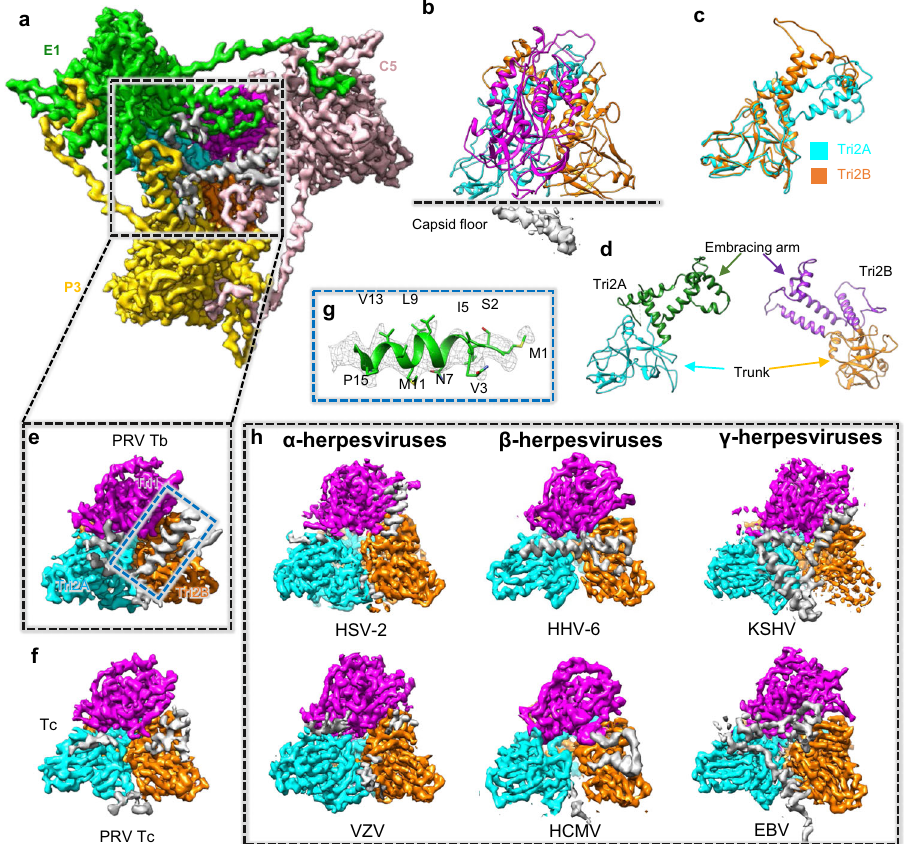
Fig. 4 Structure of the triplex and characterization of the Tri1 N-terminus. a Inside-out view of the density map of triplex Tb with surrounding MCPs. b – d Atomic model of Tb ( b ) and its components Tri2A and Tri2B ( c , d ). Superposition of Tri2A and Tri2B shows consistency in their trunk domains and conformational differences in their embracing arm domains ( c ). e , f Density maps of triplex Tb ( e ) and Tc ( f ) shows distinctions in the under- fl oor densities (colored in gray). g A close-up view of the density map (gray mesh) of the Tri1 N-terminal region with the fi tted atomic model (ribbon/sticks) shown in the dashed box. h Comparison of the under- fl oor densities of Tbs from different herpesviruses. Abbreviations: MCP Major capsid